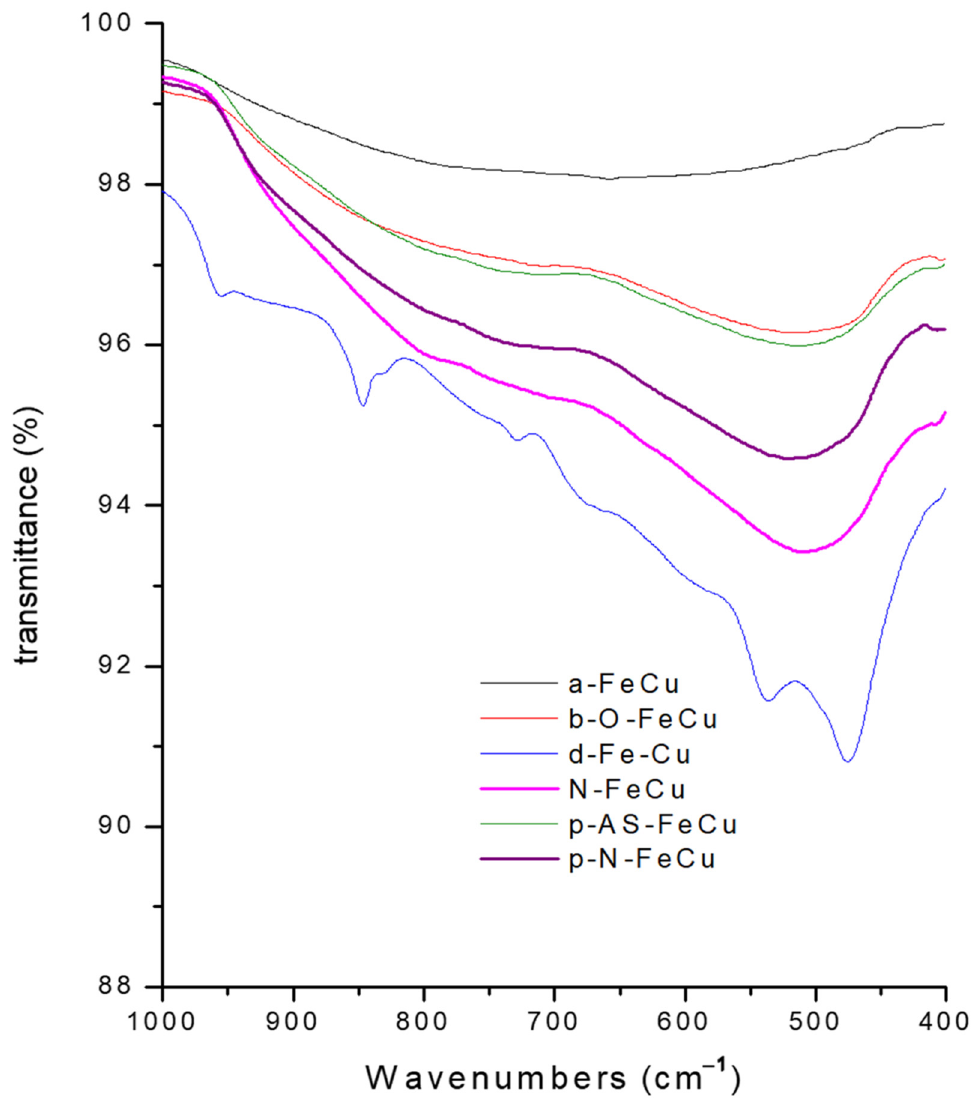
Figure 7. Acquired FTIR-ATR spectra of FeCu samples.